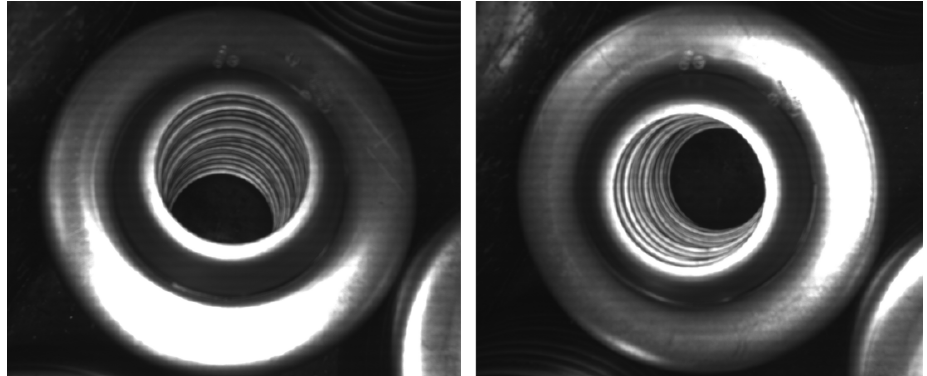
Figure 5. Comparison of two images of the manipulated part captured from different